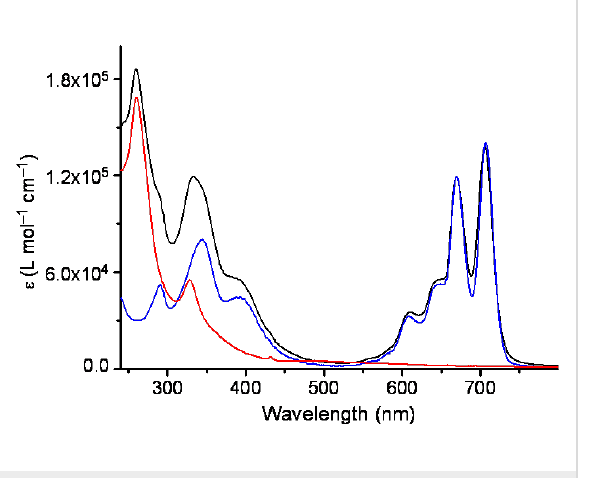
Figure 2: UV–vis absorption spectra of 2a (black), 4a (blue) and 1 (red) in CH 2 Cl 2 .